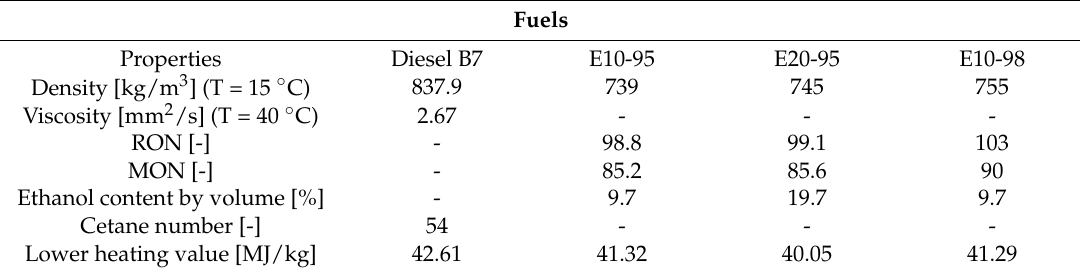
Table 6. Physical and chemical properties of the fuels used along the study.